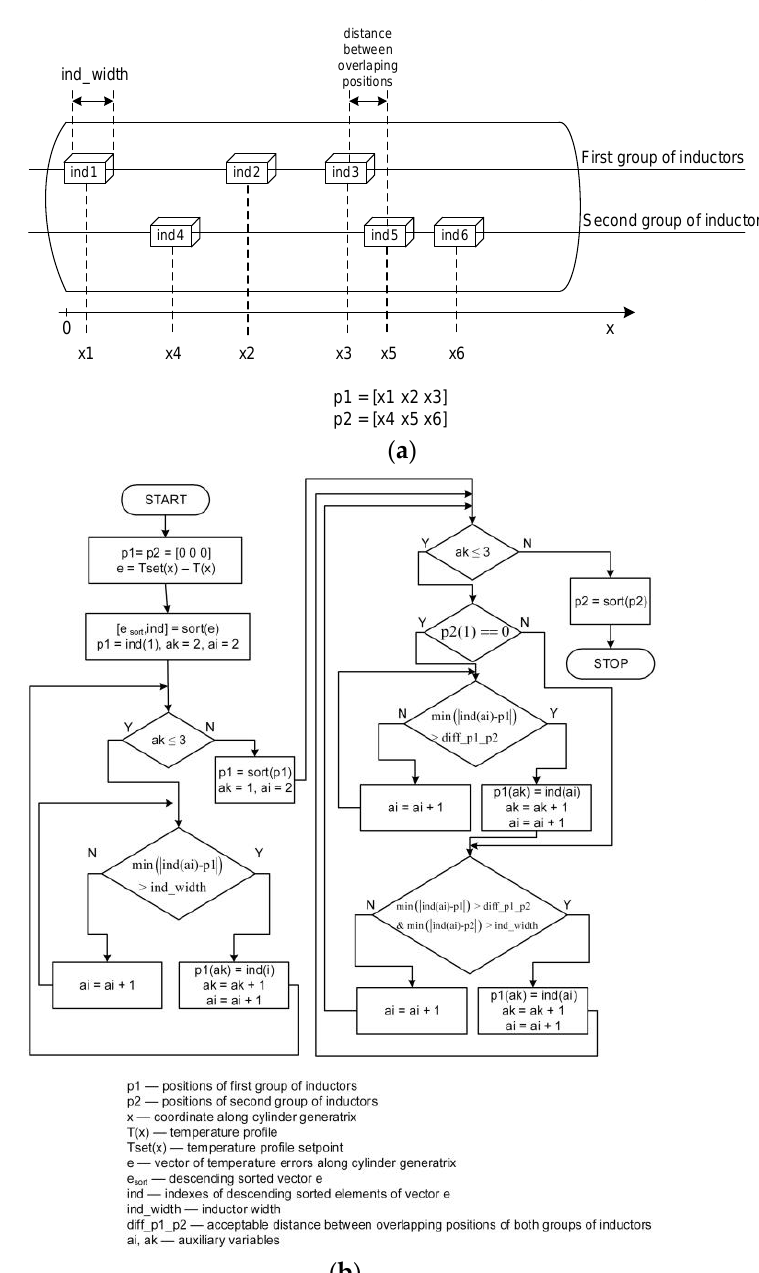
Figure 17. Scheme of the organization of inductors in a 2 × 3 arrangement ( a ) and a network of actions by the algorithm for determining the positions of the inductors along the cylinder generatrix, based on the temperature profile ( b ).